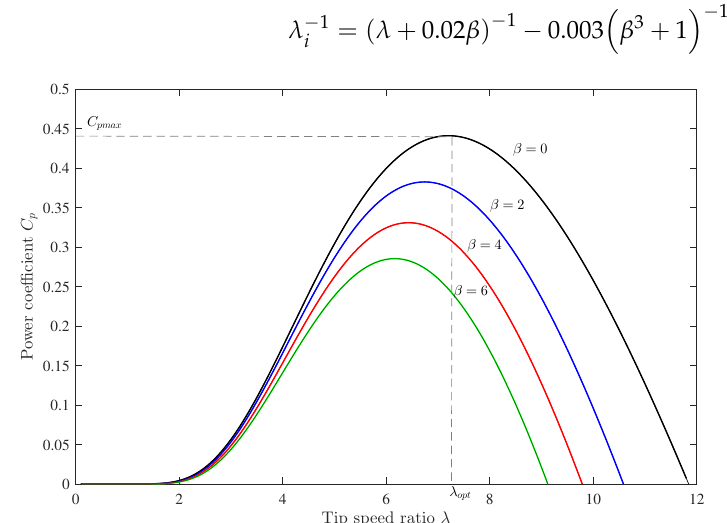
Figure 2. Power coefficient as a function of tip speed ratio.